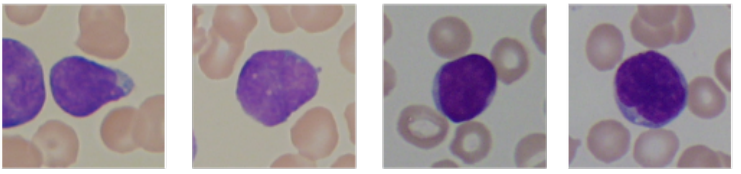
Figure 3. An example of segmented lymphocytes belonging to the leukemia